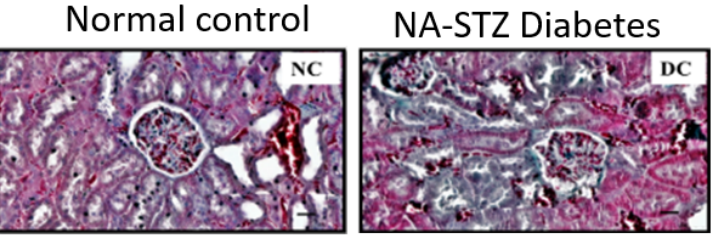
Figure 4. NA-STZ diabetic kidney histopathology stained by Masson trichrome. Kidney tissues were collected and processed for staining after 28 days of diabetes induction. This figure was repro- duced from Arigela et al. [49].